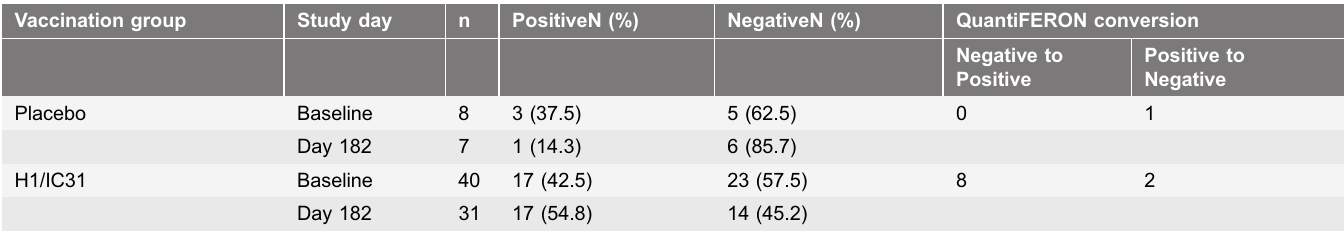
Table 3. QuantiFERON status at baseline and at day